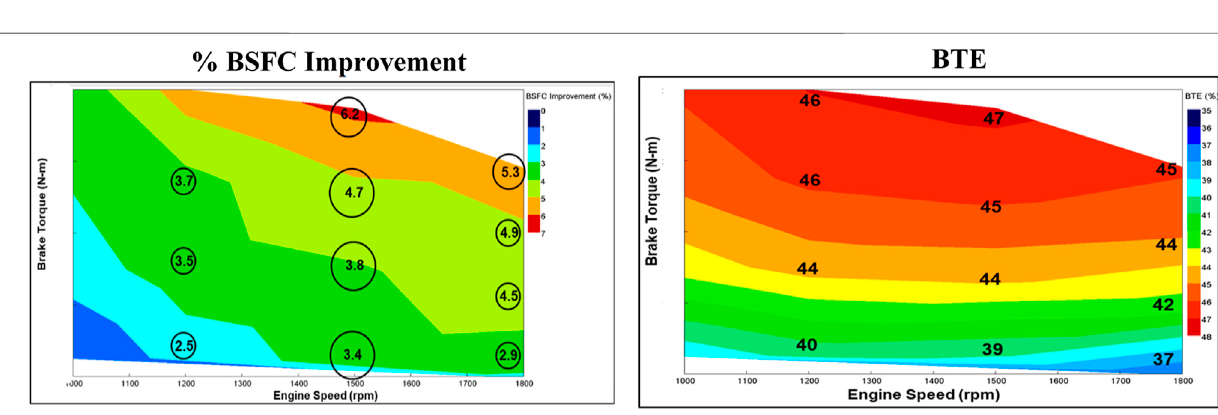
Frontiers in Mechanical Engineering |